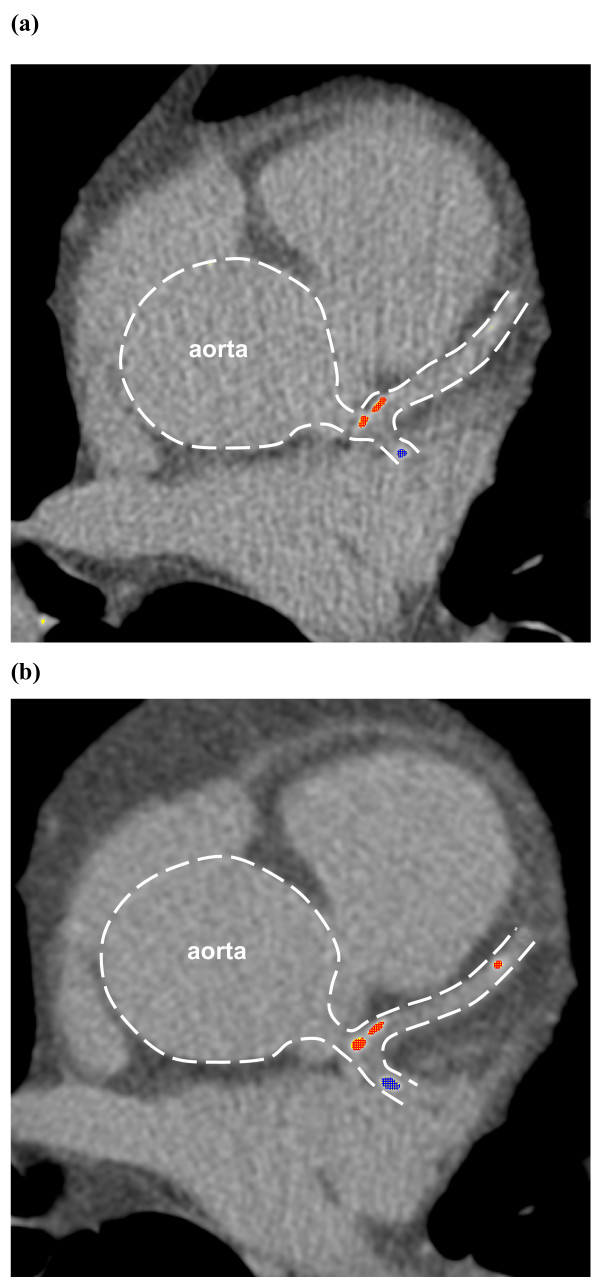
The examples of multi-detector computed tomography in a patient from the (a) placebo group at randomization and (b) after one year. a) At randomization, two calcified plaques are seen in left anterior descending artery (red colour) and one calcified plaque in circumflex artery (blue colour). Plaques volume 156.4 mm3, calcium score 138.9. b) After one year, the volume of previously observed plaques increased with the new calcification in distal part of left anterior descending artery. Plaques volume 223 mm3, calcium score 202.5.